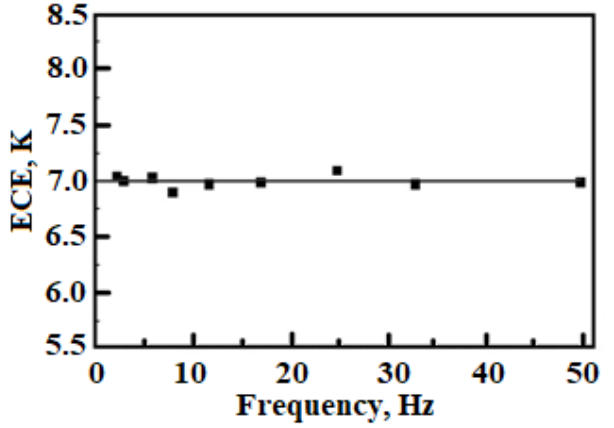
Figure 7. Dependence of ECE on the frequency of tensile and compression cycles of the sample at a maximum mechanical stress of 100 MPa at a temperature of Af.